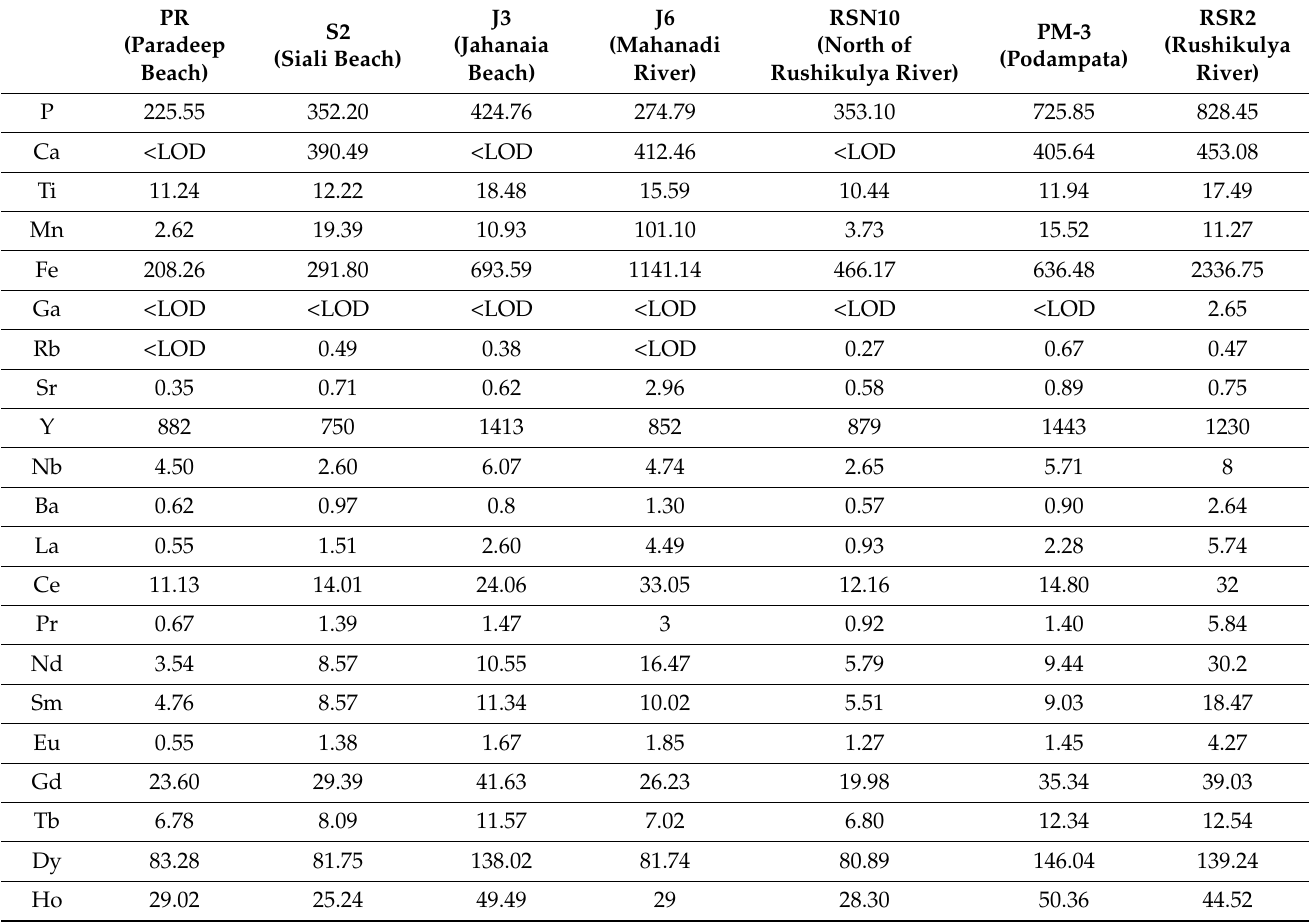
Table 1. Representative trace elements (in ppm) in zircons from various